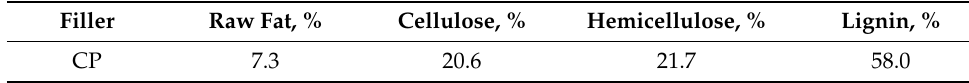
Table 7. Chemical composition of CP filler